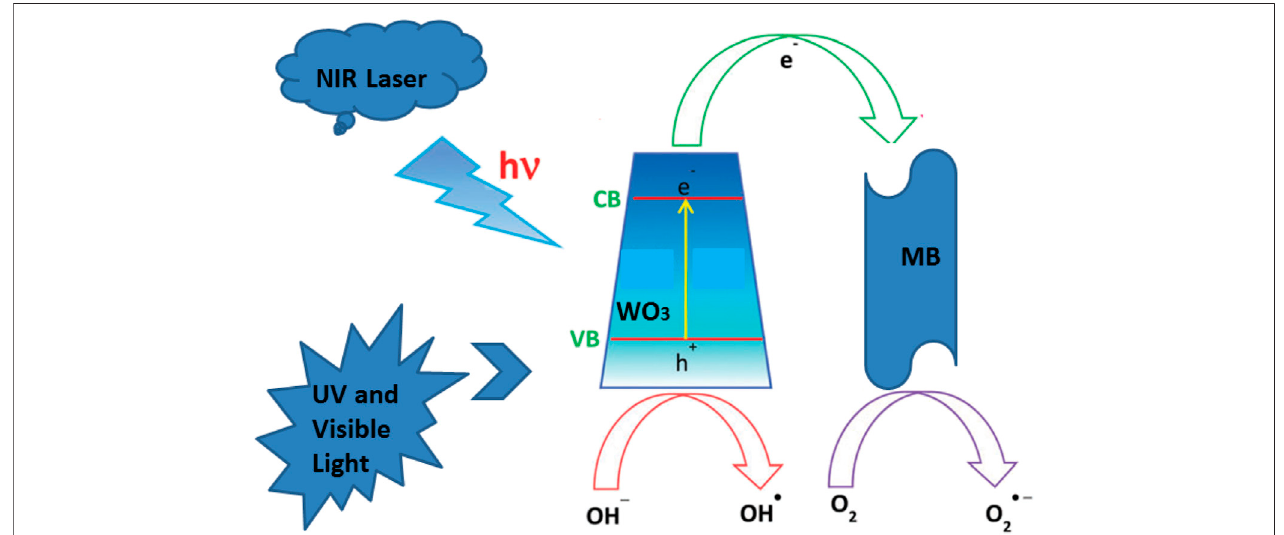
FIGURE 10 | The mechanism for the degradation of MB in the presence of the WO 3 NPs under NIR laser.